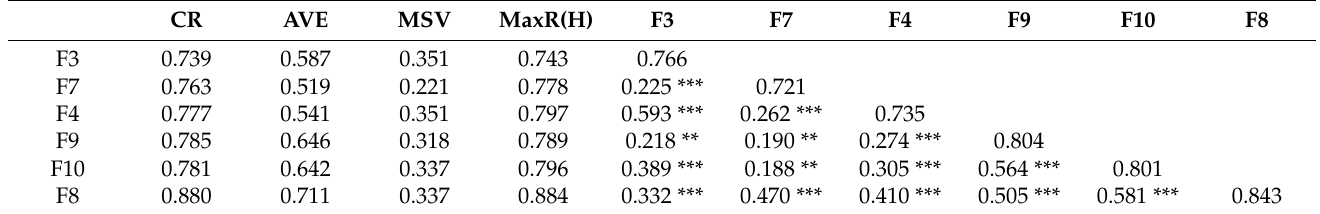
Table 2. Correlation matrix of validity of tourist destination image